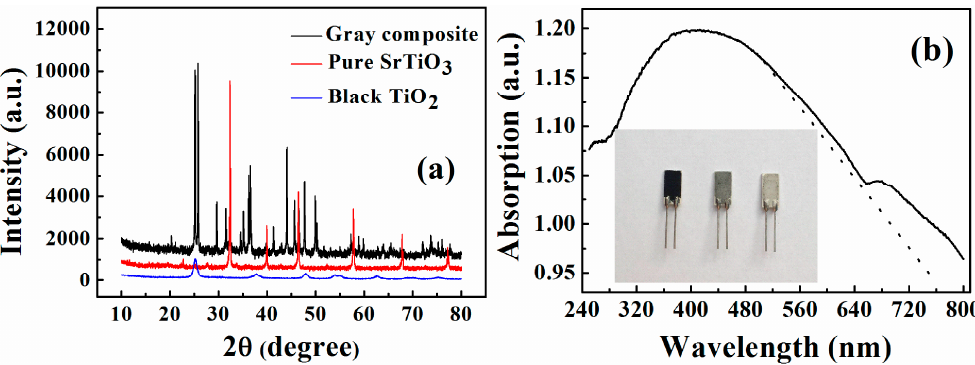
Figure 1. ( a ) X-ray diffraction (XRD) patterns of TiO 2 , TiO 2 /SrTiO 3 , and SrTiO 3 ; ( b ) UV-Visible absorption spectrum of gray TiO 2 /SrTiO 3 composite; Inset is the picture of humidity sensors based on different samples.